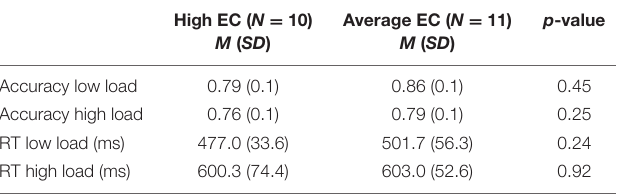
TABLE 3 | Behavioral performance on primary task